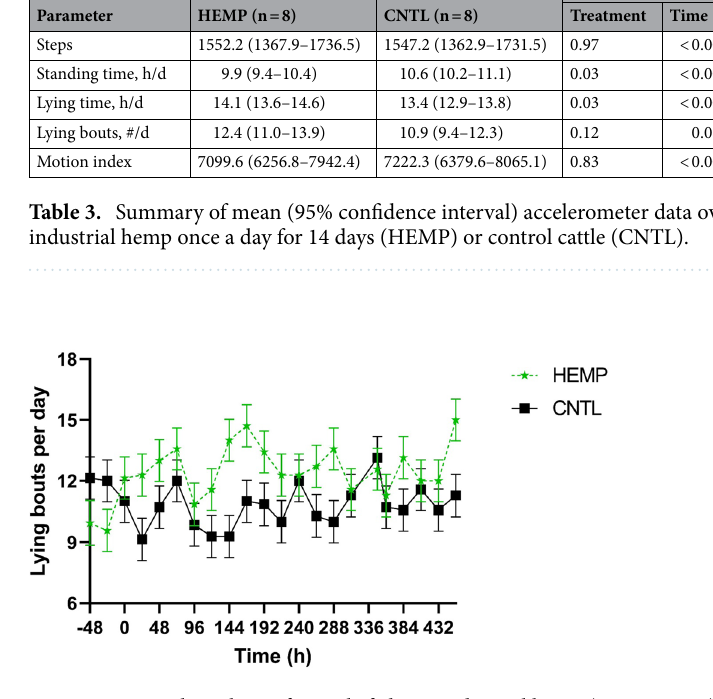
Figure 2. Mean lying bouts for cattle fed 25 g industrial hemp (HEMP; n = 8) for 14 days compared to cattle not fed industrial hemp (CNTL; n =